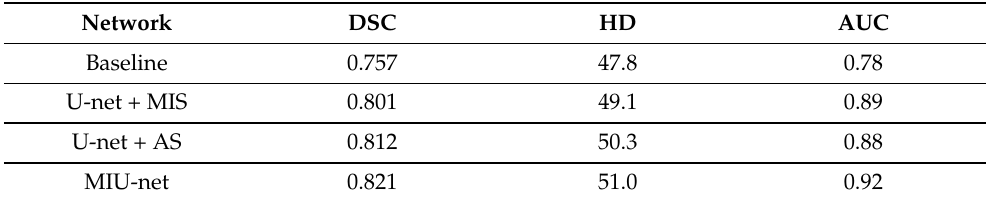
Table 3. Ablation Experiments Results.